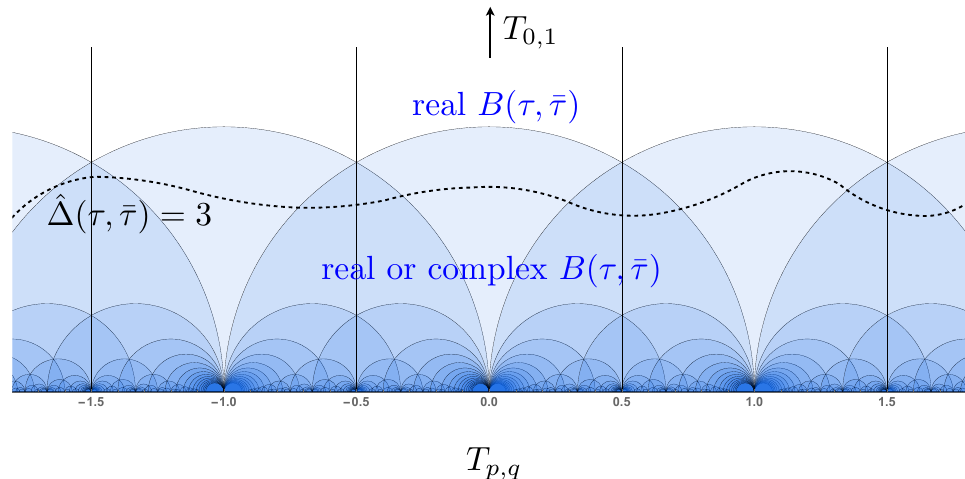
Figure 2 . A cartoon of a possible phase transition at strong coupling. A scalar boundary operator becomes marginal at a certain curve in the (cid:28) plane, i.e. setting ^(cid:1)( (cid:28); (cid:22) (cid:28) ) = 3 we (cid:12)nd solutions in the upper-half plane. In conformal perturbation theory from a point on the curve, the beta function takes the form (2.51). We might be unable to (cid:12)nd real (cid:12)xed points for the marginal coupling. In such a situation, B ( (cid:28); (cid:22) (cid:28) ) can only be de(cid:12)ned as a complex BCFT. Assuming that we were able